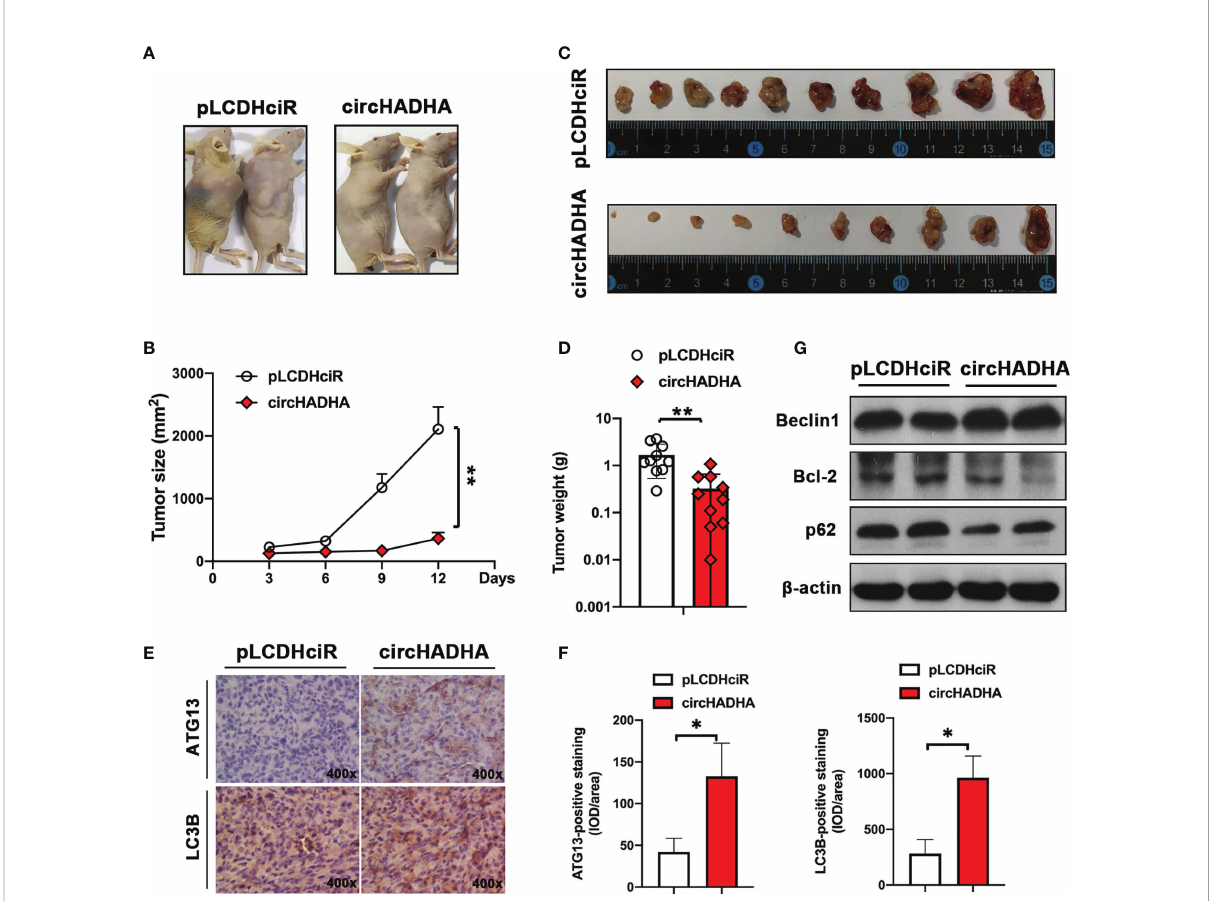
FIGURE 7 CircHADHA suppressed tumor growth in colon cancer cell-derived xenograft-bearing nude mice. (A) The generation of xenograft-bearing nude mice by subcutaneously transplanting with circHADHA-overexpressing or control LoVo cells. (B) The tumor size was measured every 3 days. The tumor growth was signi fi cantly inhibited in circHADHA-overexpressing LoVo-derived xenograft compared to control tumors. (C) Xenograft tumors were isolated from nude mice on the 12th day after xenograft transplantation of circHADHA-overexpressing or control LoVo cells. (D) The average weight of xenograft tumors derived from circHADHA-overexpressing or control LoVo cells. Overexpression of circHADHA signi fi cantly suppressed xenograft tumor growth. N = 10. (E) Immunohistochemical staining of ATG13 and LC3B in xenograft tumors derived from circHADHA-overexpressing or control LoVo cells. circHADHA overexpression increased the expression of ATG13 and LC3B in xenograft tumors. (F) The staining intensity of ATG13 (left panel) and LC3B (right panel). (G) Autophagy-related proteins were measured by Western blot. Beclin1 was expressed higher in xenograft with circHADHA overexpression than in control tumors. Bcl-2 was decreased and p62 was degraded in circHADHA-derived xenograft compared with control tumors. **P < 0.01; *P <